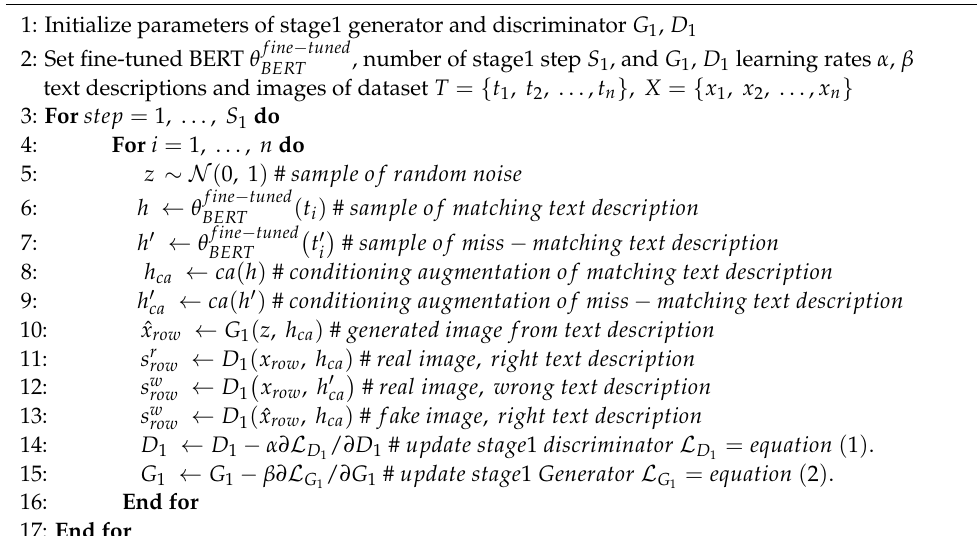
Algorithm 2 Low-Resolution Image Generation from Text by Using BERT-Based